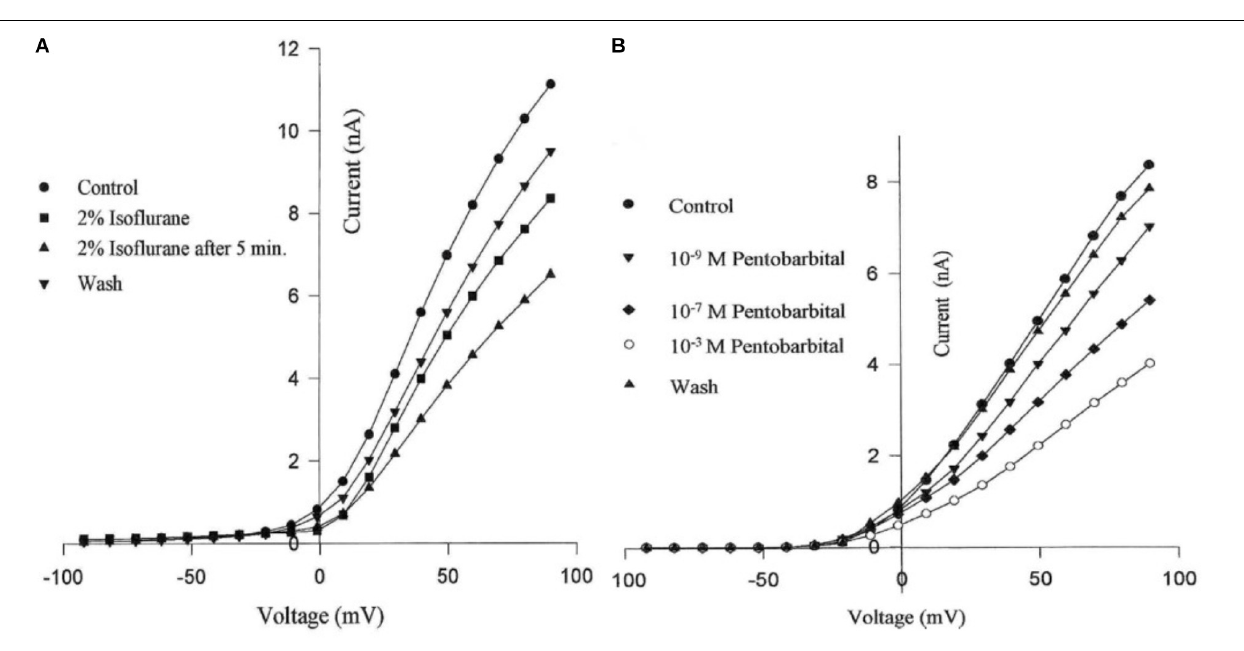
FIGURE 4 | Suppression of potassium currents by both isoflurane (A) and sodium pentobarbital (B) in cultured pedal I cluster neurons of Lymnaea , using the whole cell voltage clamp technique. (From Moghadam, 1996 - Reproduced under the Creative Commons